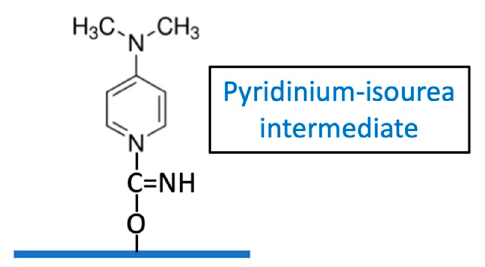
Figure 11. Proposed pyridinium–isourea structure as an intermediated in CDAP activated Figure 11. polysaccharides.